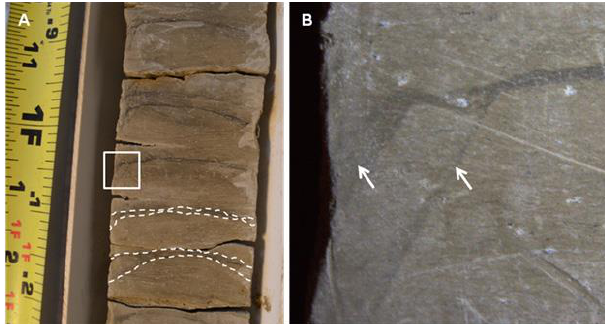
Figure 7. Evidence for drilling disturbance in the Wilson Lake B core; new photographs of part of a polished half-round interval pre- pared originally by Wright and Schaller (2013). (a) Alternating core discs and injected slurry, thickening to the edges (highlighted) with deformation features at the edge of the core. (b) Microscopic detail of highlighted area in (a) showing fractured (micro-faulted) core injected with drilling slurry (darker color, highlighted with arrow). Very similar fracturing features occur in the three overlying core discs in (a) .